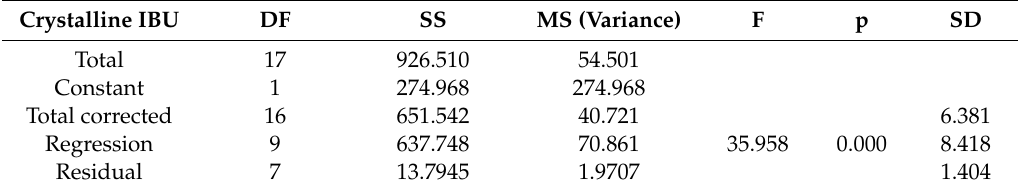
Table 2. Statistical significance of factor e ff ects based on the ANOVA analysis.